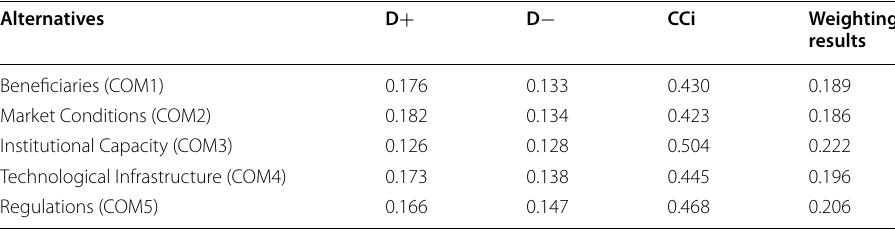
Table 10 Analysis results for the phase 3 of QFD